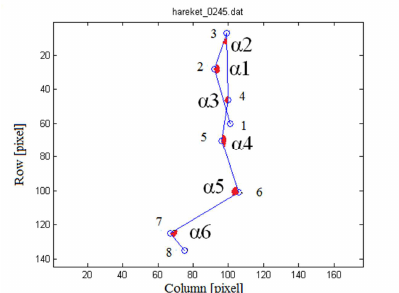
Figure 8. Target points and the angles on the first of consecutive frames